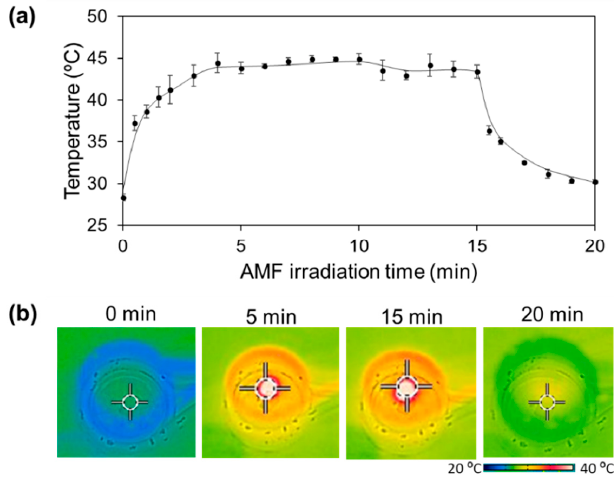
Figure 4. ( a ) AMF-responsive heating/cooling profiles of the MNPs-loaded fiber mesh. AMF was irradiated for 15 min and then turned off. ( b ) The infrared thermal images of the MNPs-loaded fiber mesh in a copper coil.